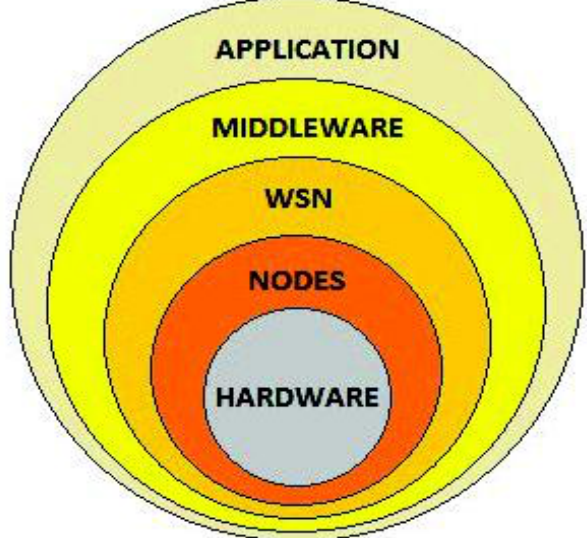
Figure 1. Dependence relations among the main components of a ubiquitous